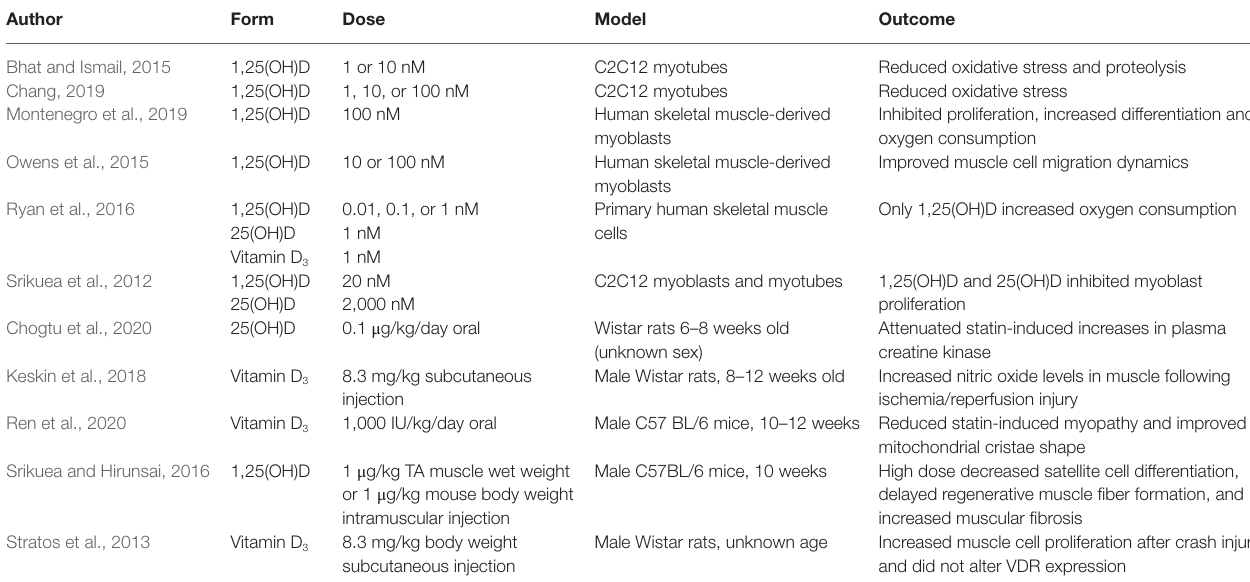
TABLE 2 | Forms and doses of vitamin D analogs vary significantly across